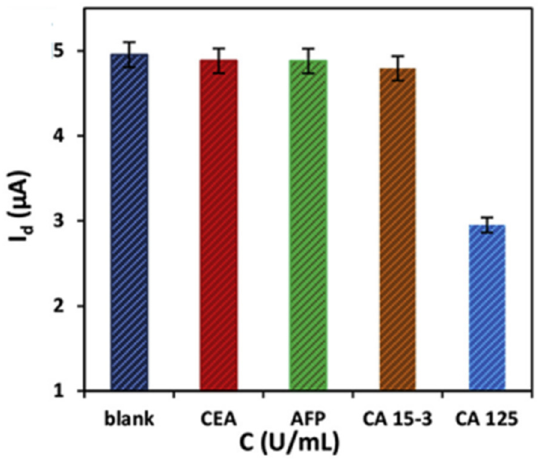
Figure 7. A histogram details the sensing performance of the few-layer RGO FET aptasensor. Reprinted with permission from ref. [125]. Copyright 2018, Elsevier.